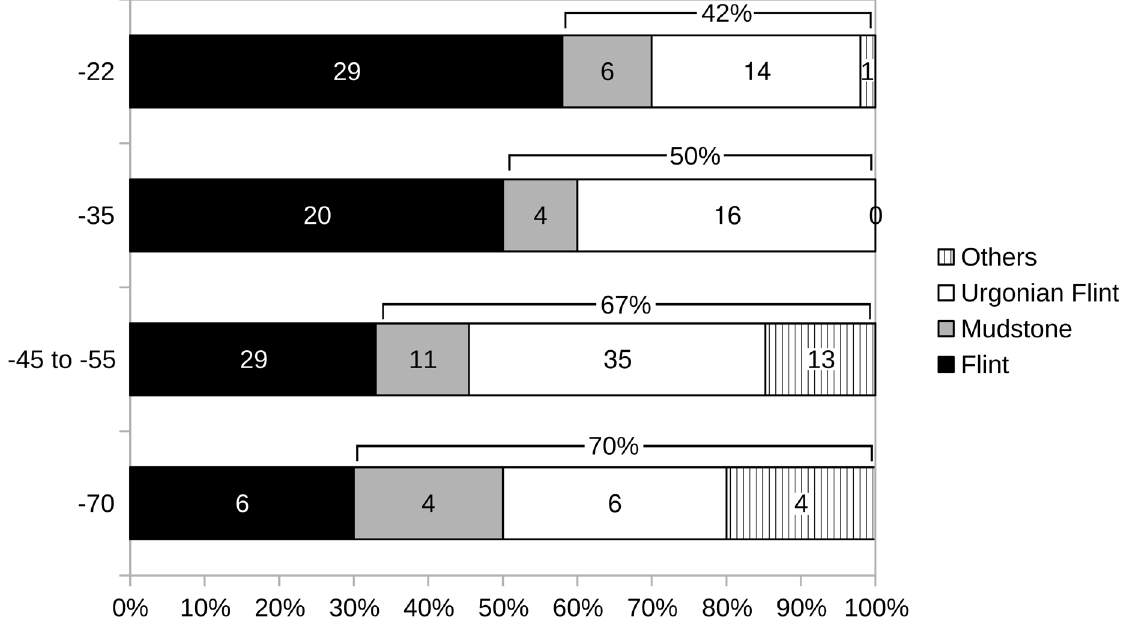
Figure 3. Raw material composition at different level depths, -22 cm (level I); -35 cm (level II); -45 cm to -70 cm (level